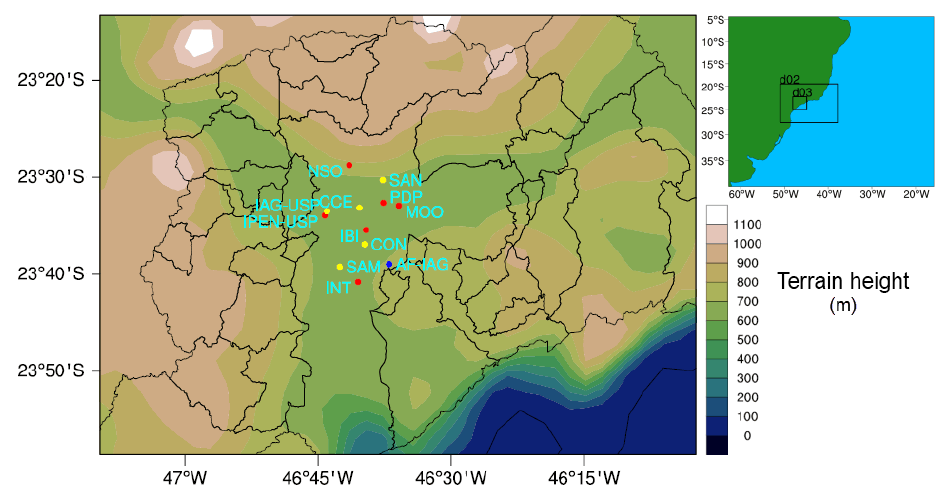
Figure 1. Downtown area of the 3km modelling domain (d03) showing the locations of measurement sites and WRF topography in the vicinity of the SPMA. Red dots represent sites with information on O 3 and PM. Yellow dots represent only sites with information on PM. Blue dot represents the location of the IAG-USP’s climatological station. Table 2. Description of measurement sites. Site Initials Latitude Longitude Classification Measured species Nossa S. do O NSO − 23.4796